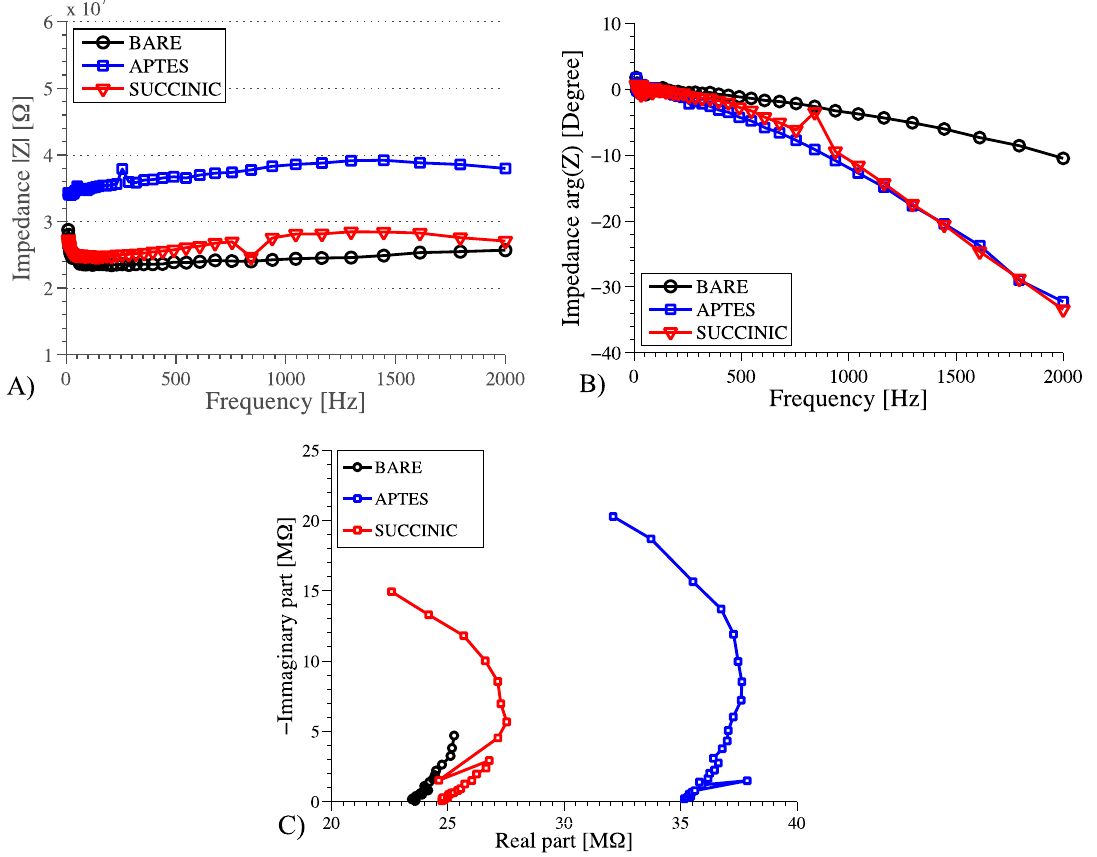
Figure 11. ( A ) AC impedance magnitude and ( B ) phase measurements showing how different surface chemistries can be discriminated. Simple DC measurements show no difference; ( C ) Cole-Cole plot of the same data.